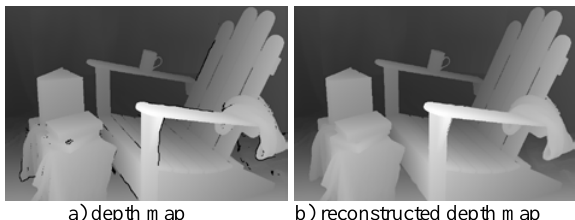
Fig. 7. Processing example.